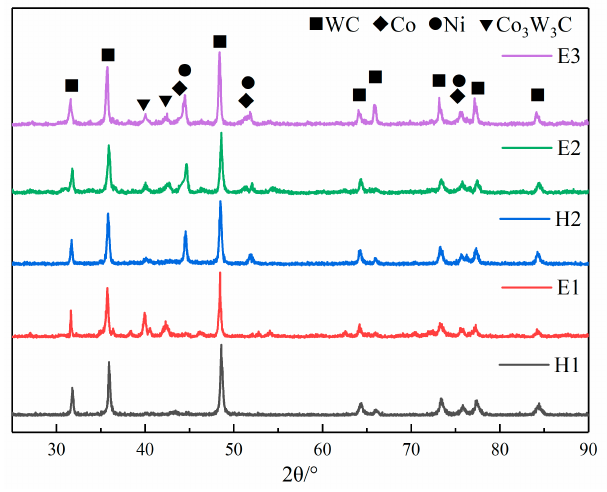
Figure 7. XRD before corrosion.